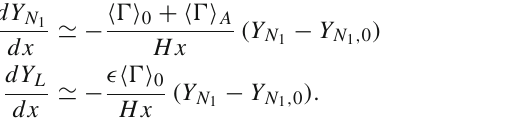
Fig. 2 The dependence of the lepton asymmetry | Y L | in the model for low-scale leptogenesis, as a function of the ratio of CP-conserving and violating decay widths, (cid:9) (cid:7) (cid:10) A / (cid:9) (cid:7) (cid:10) 0 . In this model, the CP-violation parameter (cid:8) can be expressed in terms of (cid:7) A , for fixed values of the scalar quartic coupling λ and tan β . See text for